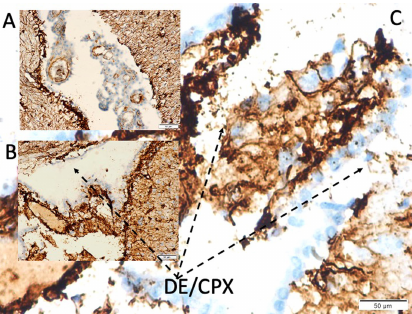
Figure 2. In the control group, normal choroid plexus (CPX) is observed in the lateral ventricle, and mild degeneration is observed in the sham group. In the study group, atrophic CPX, damaged/missing ciliary appendages, degenerated ependymal cells with dark nuclei, and dense cytoplasm are observed in a dilated